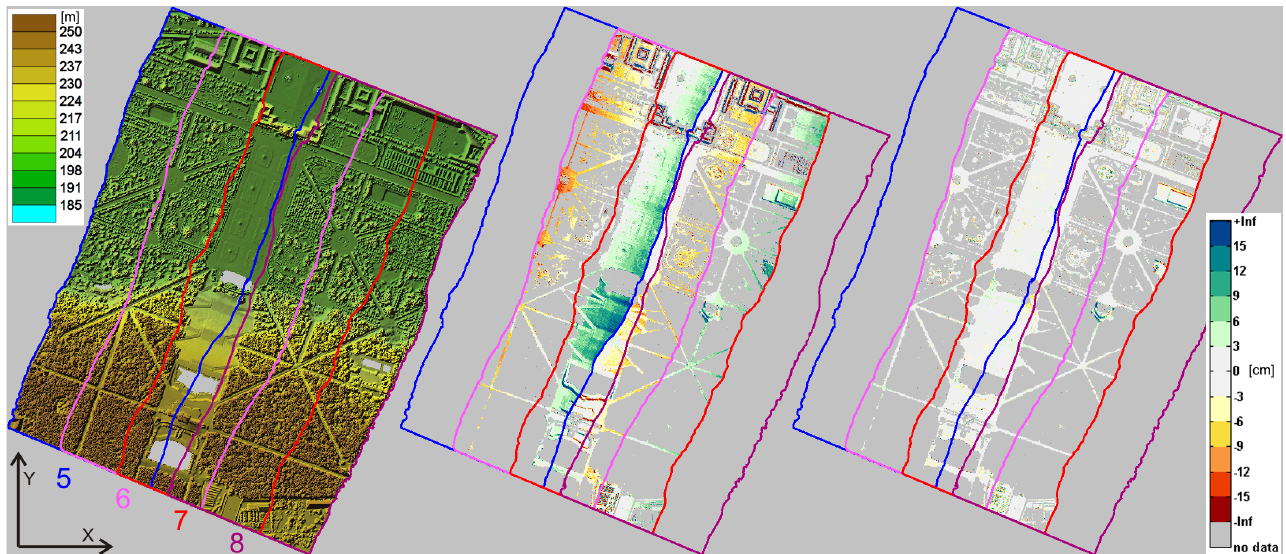
Figure 2: Left: combination of height colour coding and shading. Middle: Stack of masked colour coded strip differences for the original georeferencing. Right: Stack of masked colour coded strip differences for the improved georeferencing after the strip adjustment. Note that due to strip overlap of ca. 70% parts of the differences are not visible in the